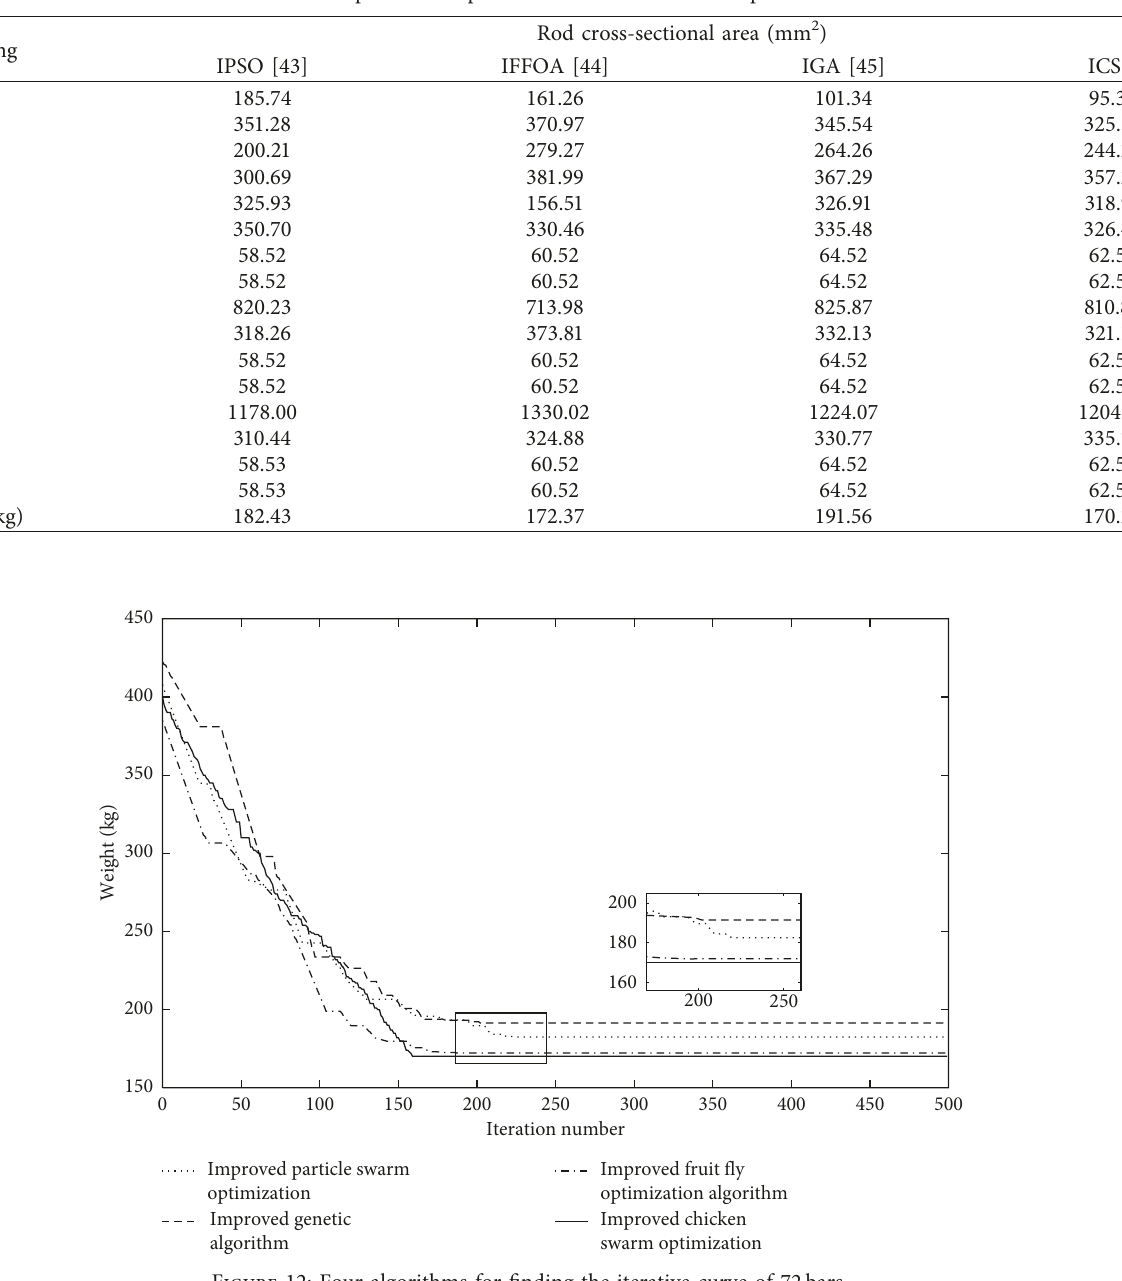
Table 11: Comparison of optimization results for 72bar space